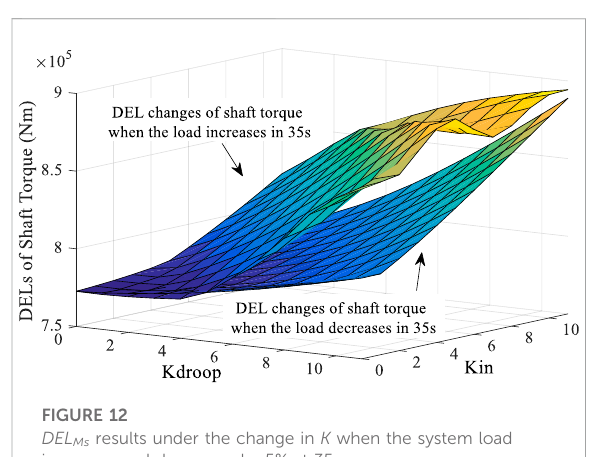
FIGURE 13 DEL Mt results under the change in K when the system load increases and decreases by 5% at 35